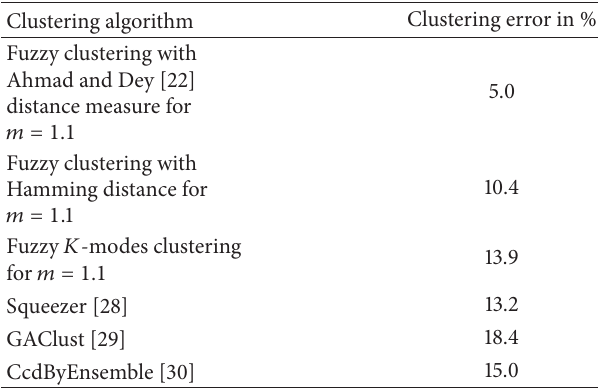
Table 8: Confusion matrix for the average clustering result with Ahmad and Dey [22] distance measure, for 𝑚 = 1.9 .